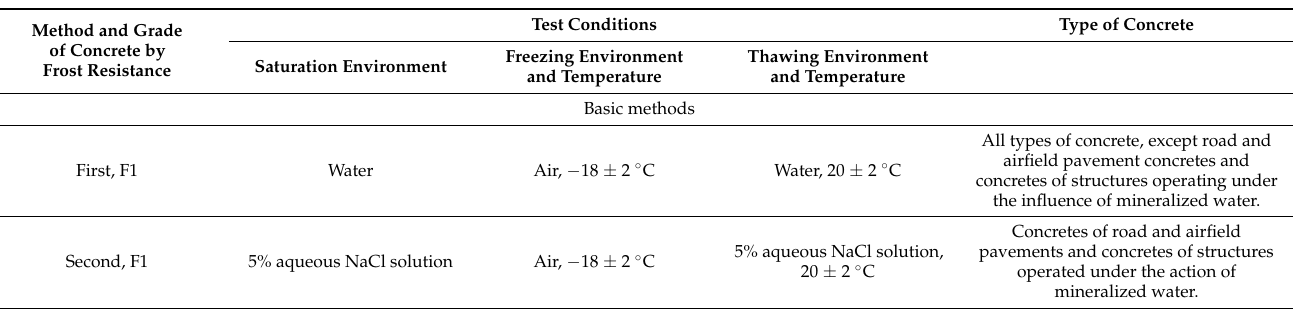
Table 11. Test mode